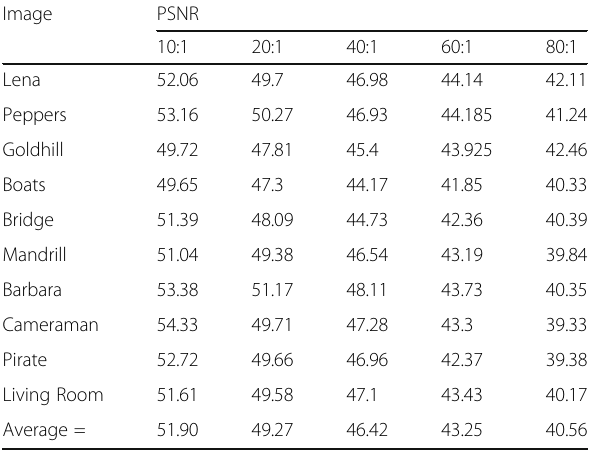
Table. 3 CR and PSNR values obtained for standard images (DB3)